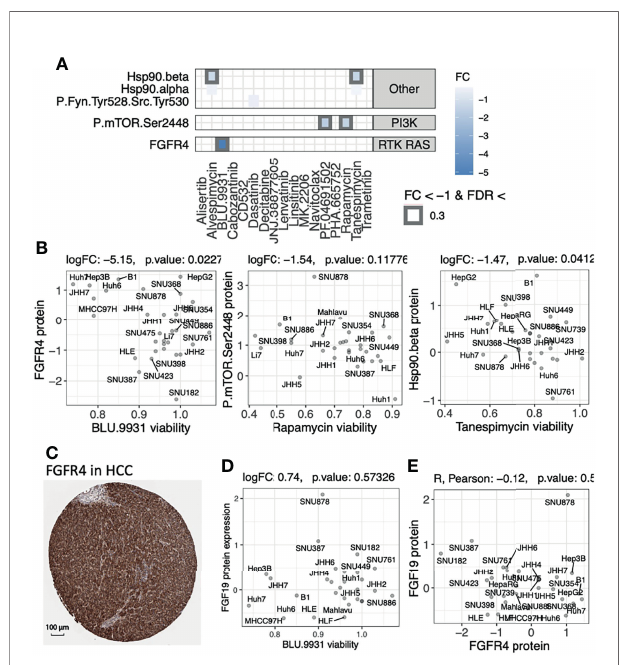
FIGURE 5 | Evaluating the therapeutic ef fi cacy of overexpressed protein targets found in primary tumors using drug screen data of human HCC cell lines. (A) Expression-driven dependency analyses highlight protein targets showing association between high protein expression and low cell viability upon treatment using drug compounds in a cohort of human HCC cell lines. (B) Scatter plots of the associations between cell viability and protein expressions of each compound ’ s respective target genes shown in panel (A) (C) IHC staining from the Human Pathology Atlas supporting the expression of the targeted kinase that showed signi fi cant expression-driven dependency. (D) The lack of correlation between BLU.9931 cell viability and FGF19 protein expression. (E) The lack of correlation between the protein expressions of FGFR4 and FGF19 genes in the HCC lines.